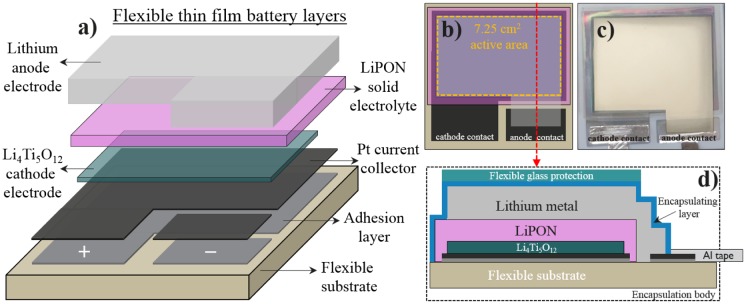
(a) Schematic representation of the flexible thin-film battery layers. (b) Top view representation of the layers showing the 7.25 cm2 active area (c) Top view photograph of a real flexible thin-film battery device. (d) Cross section representation of the fully encapsulated battery stack showing all final components.